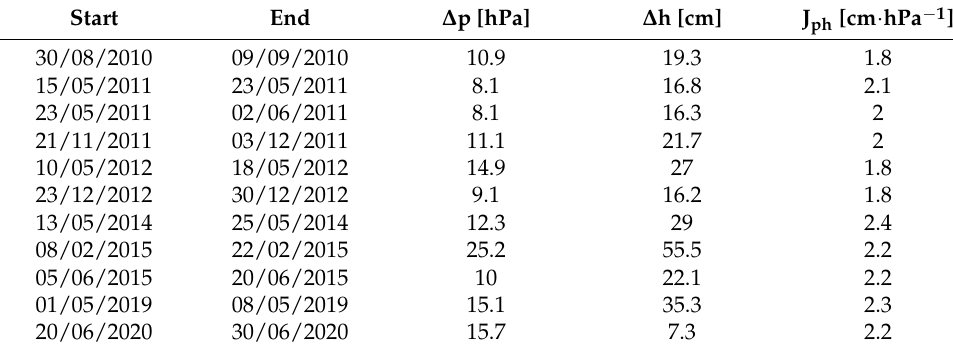
Table 2. Significant events occurred since 2010 in the port of